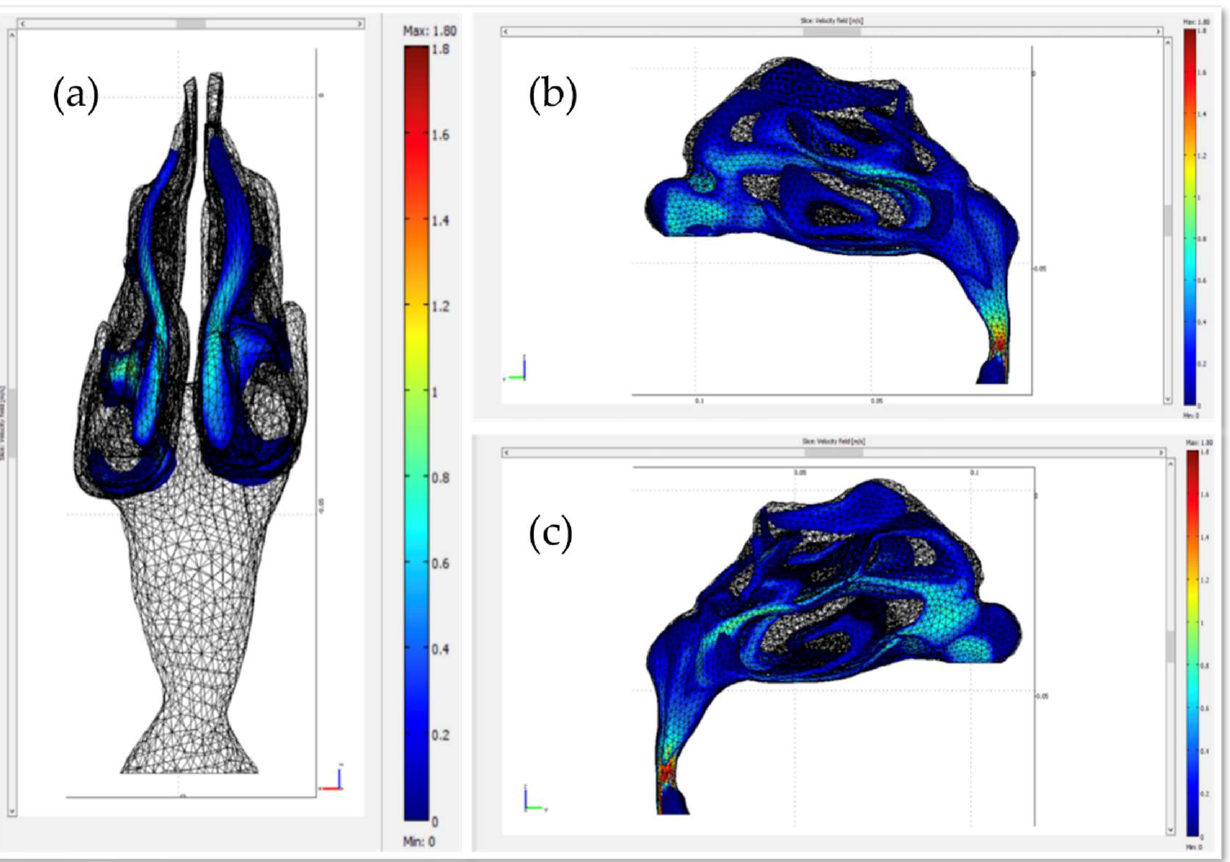
Figure 5. Plot of the air velocity field within the nasal cavity. ( a ) plane zx, ( b ) plane yz ( c ) plane yz rotated 180 ◦